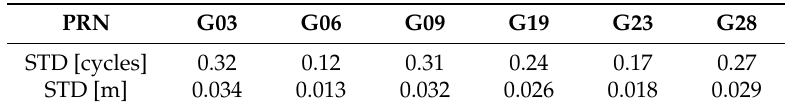
Figure 6. Narrow-lane uncalibrated phase delay of the GPS satellite between the 187th and the 193th day of 2016. Table 2. Narrow-lane uncalibrated phase delay STD of the GPS satellite between the 187th and the 193th day of